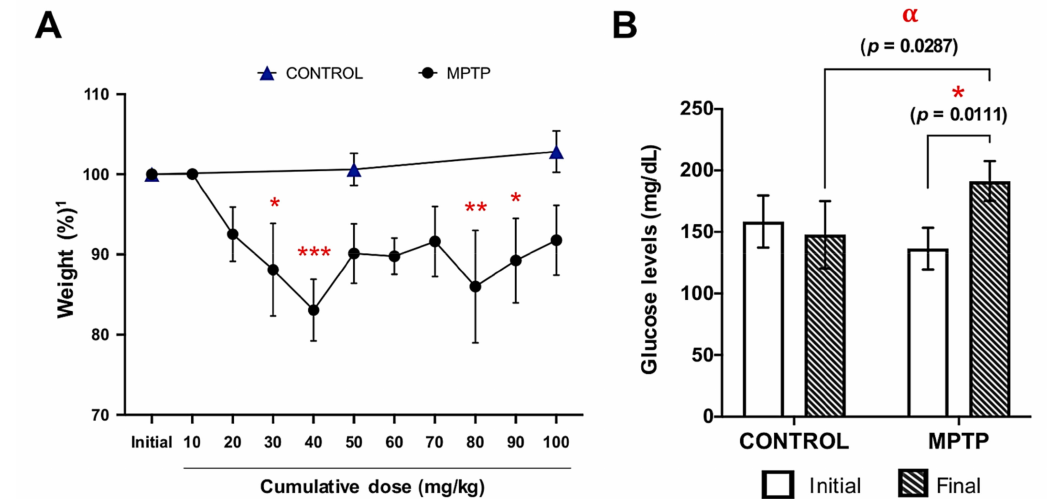
Figure 1. Weight and glucose levels are affected by MPTP intoxication. ( A ) Animals’ weight evolution along the experiment, expressed as percentage relative to their own initial weight 1 . Symbols: * at 30 mg/kg means p = 0.0122; *** at 40 mg/kg means p = 0.0001; ** at 80 mg/kg means p = 0.0018; * at 90 mg/kg means p = 0.0327). ( B ) Glucose levels were measured at two time points in both groups: before the MPTP injections started (initial) and the day the animals were euthanized (final). * Corresponds to p = 0.01 when initial MPTP vs. final day MPTP; α corresponds to p = 0.0287 when control final day vs. final day MPTP. Data are expressed as mean ±